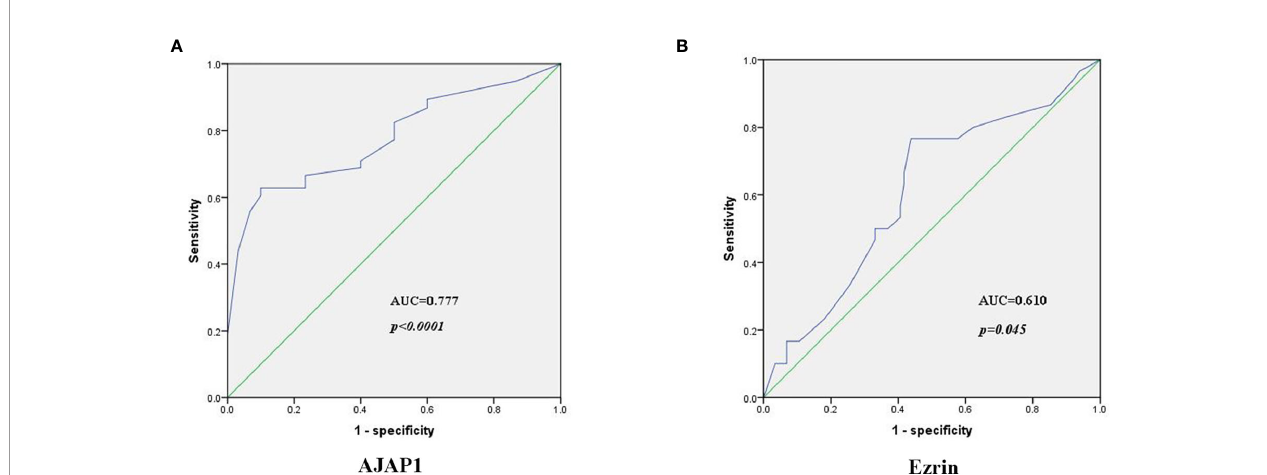
FIGURE 4 | The diagnosis power of AJAP1 (A) and Ezrin (B) expression in breast cancer